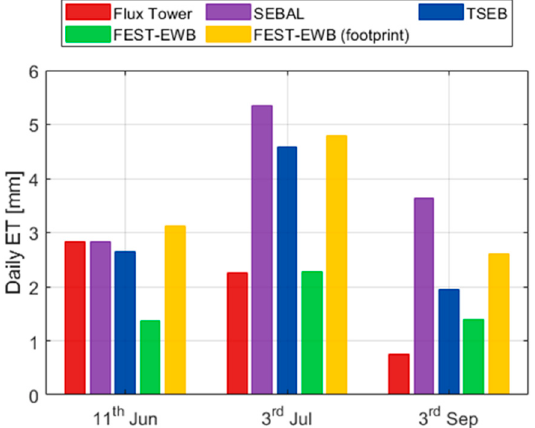
Figure 7. Average daily evapotranspiration for the main experimental area computed from the eddy covariance measurements (Flux Tower), the SEBAL, TSEB and FEST-EWB models (both pixel-wise and corrected by station footprint).